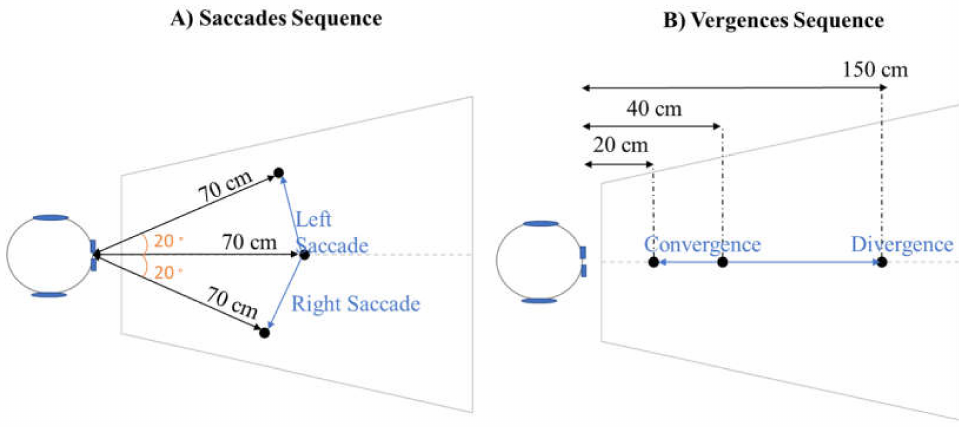
Figure 2. Saccade and vergence sequences on the REMOBI device. ( A ) Top-view of the position of the LEDs for the saccade sequence. ( B ) Top-view of the position of the LEDs for the vergence sequence. The saccade sequence comprises 20 trials of right saccades and 20 trials of left saccades, randomly interleaved. During each trial, a central LED, situated at 70 cm in front of the participant (the same distance from his left and right eye), is switched on at a random time between 1200 and 1800 ms. Then, a lateral LED to the right or to the left is lit for 2000 ms, following an overlap paradigm, i.e., the central LED switches off 200 ms after the onset of the lateral LED. The lateral LED forms an angle of 20 ◦ with the central LED, calling for a left saccade or right saccade of 20 ◦